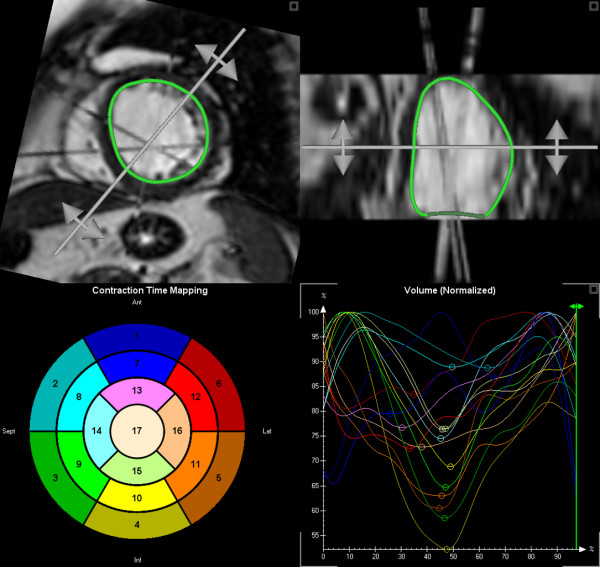
Semi-automatically segmented left ventricle (upper panels) with plot of segmental volume-time curves (right lower panel) and bulls eye plot of the 17 segment model (left lower panel).